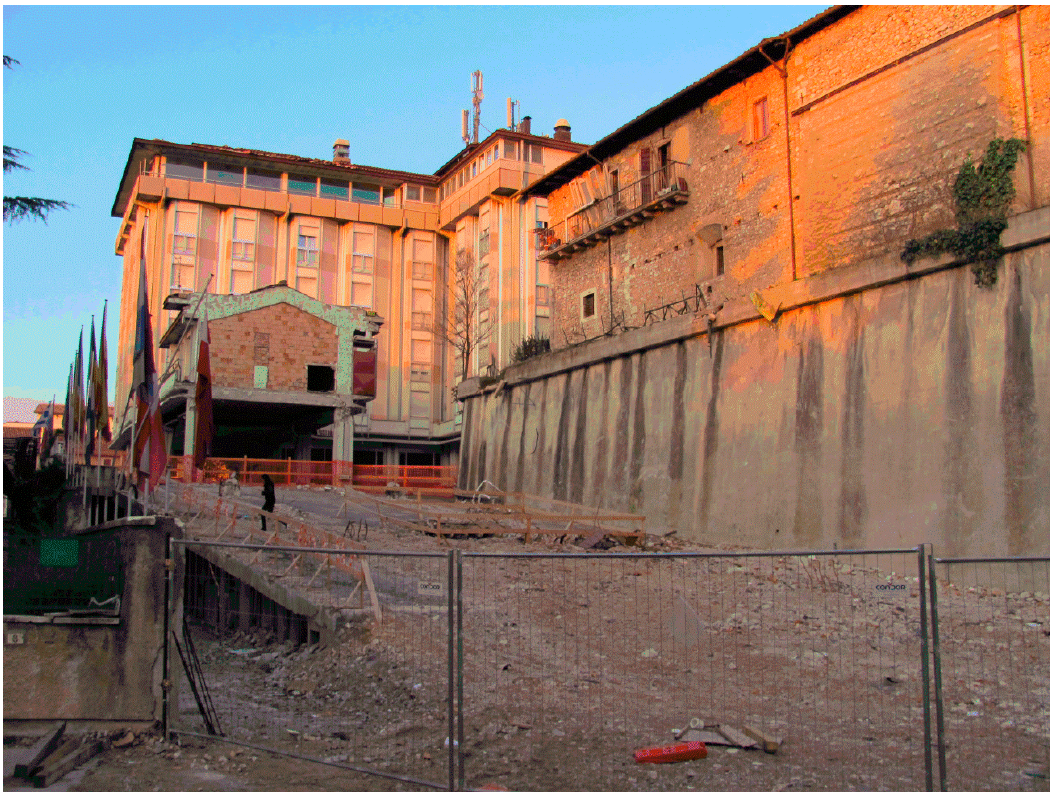
Figure 1. The city center after the event.